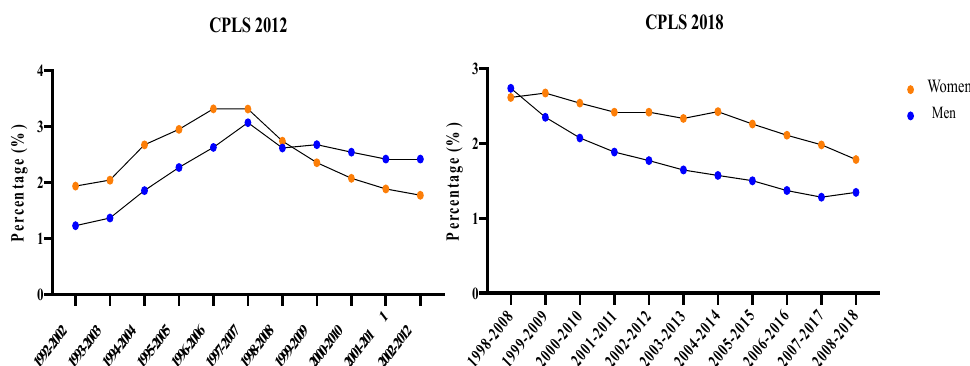
Figure 2. Variation of the mean salary in 10-year periods in people aged 20 to 30 years in Spain, (1992–2018). Source: Our own elaboration from the Spanish CPLS 2012 and 2018.